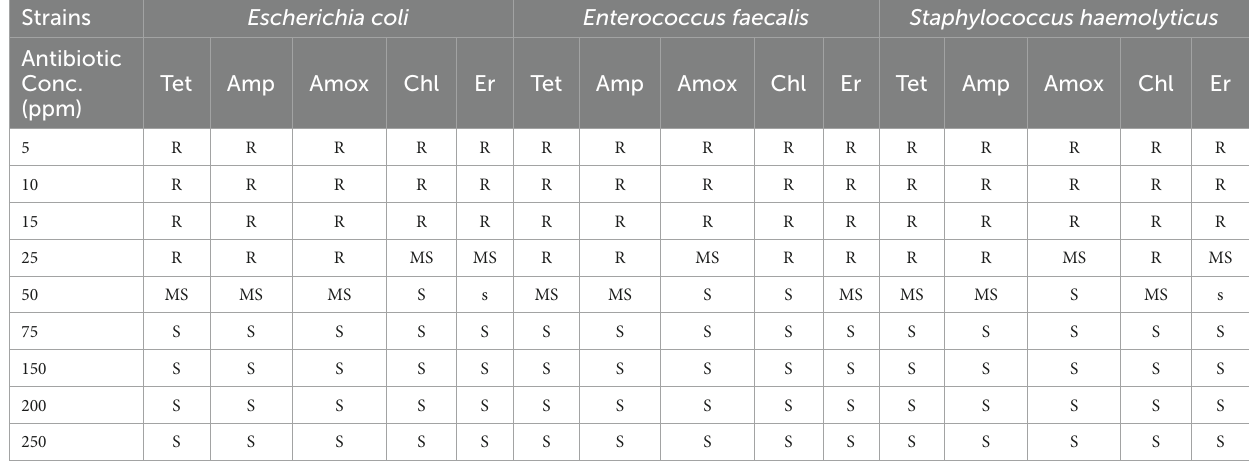
TABLE 2 Antibiotic resistance profiles for the selected isolates AH-03, AH-07, and AH-13. Strains Escherichia coli Enterococcus faecalis Staphylococcus haemolyticus Antibiotic